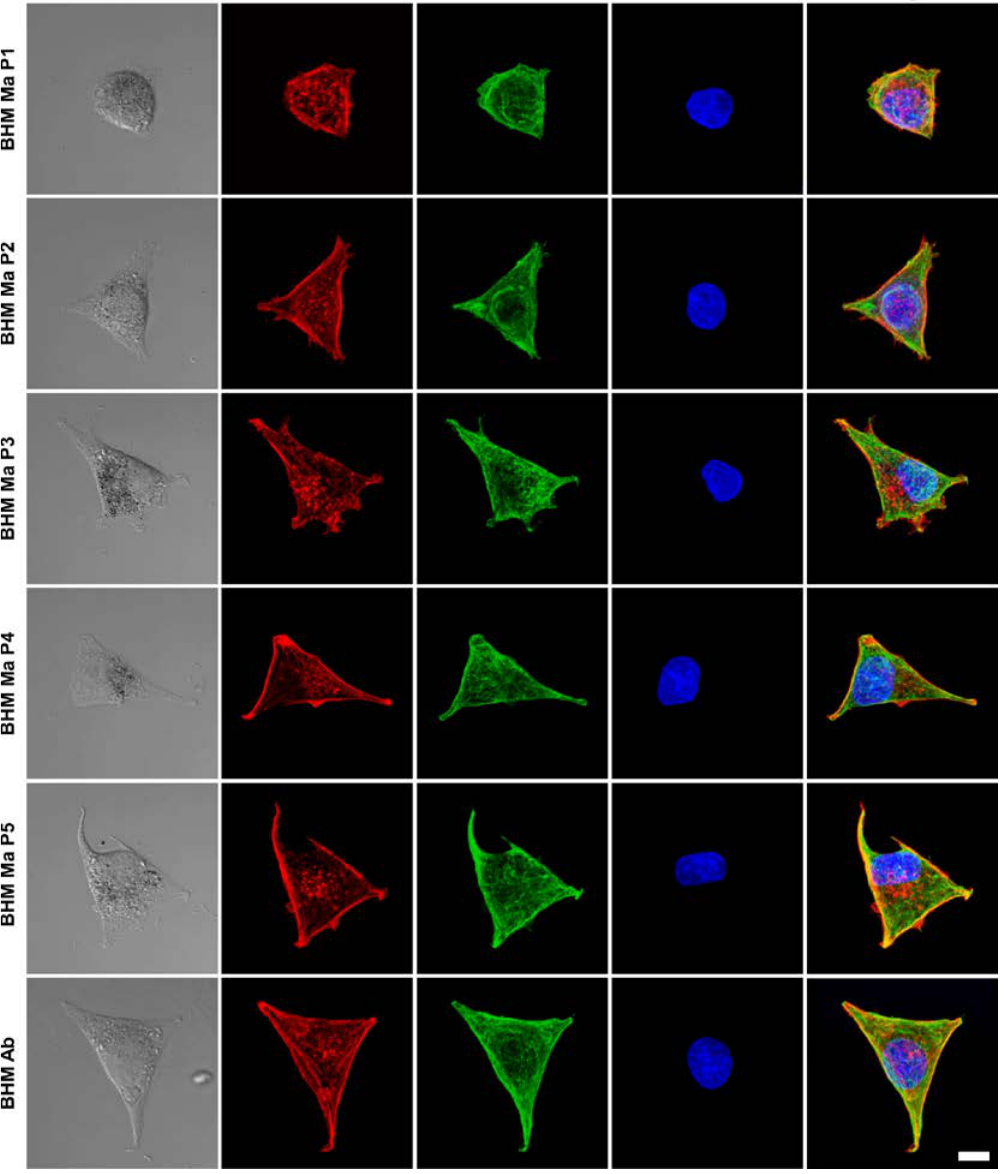
Figure 3. Representative confocal microscopy images of the examined cells. Scatter laser light images (first column from the left) showing the morphology of the cells followed by fluorescence images (remaining columns) of the cells’ cytoskeleton shown in the maximum intensity projection mode. Scale bar for all images represents 10 µm.